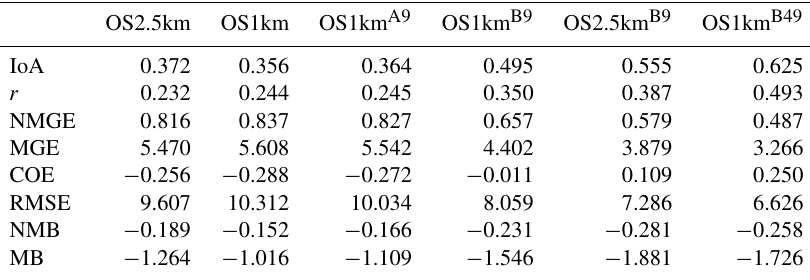
Table B7. Surface PM 2 . 5 observations to model comparison, daytime (09:00–18:00LT) (µgm − 3 , 1862 model–observation